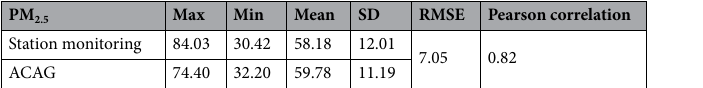
Figure 4. Analysis framework used in this study.